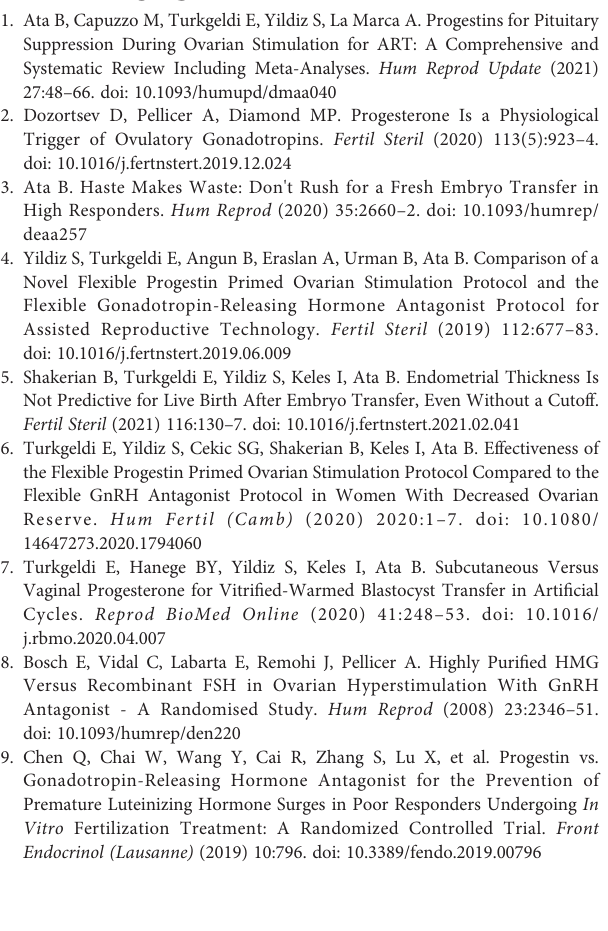
Supplementary Figure 1 | Propensity score histograms in fl exible progestin primed ovarian stimulation (treated) and antagonist (control) cycles. Female age was categorised into <30, 30-35, 35-38, 38-40, >40 years to facilitate matching. Propensity score matching was performed on initial gonadotropin dose and female age. Supplementary Figure 2 | Propensity score histograms in fl exible progestin primedovarianstimulation(treated)andantagonist(control)cycles.Femaleagewas categorised into <30, 30-35, 35-38, 38-40, >40 years to facilitate matching. Propensityscorematchingwasperformedoninitialgonadotropindose,femaleage, and transferred embryo